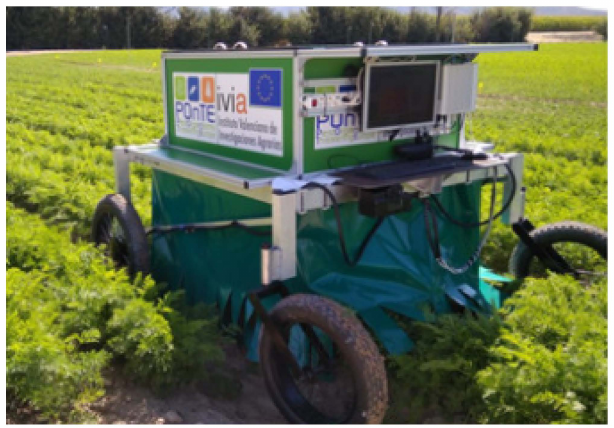
Figure 10. A remotely-driven RobHortic operating in a carrot field, showing the external appearance of the robot